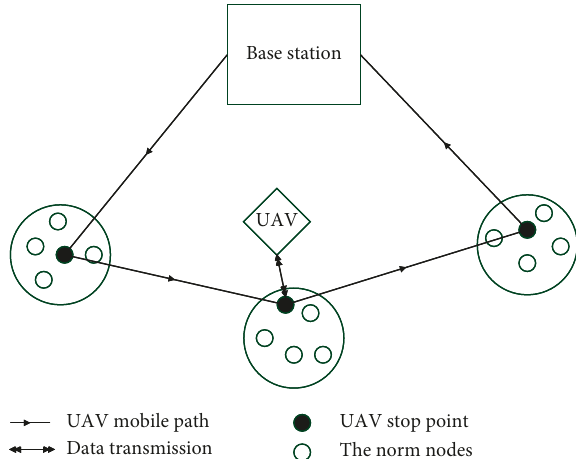
Figure 1: Overall structure diagram of the system.